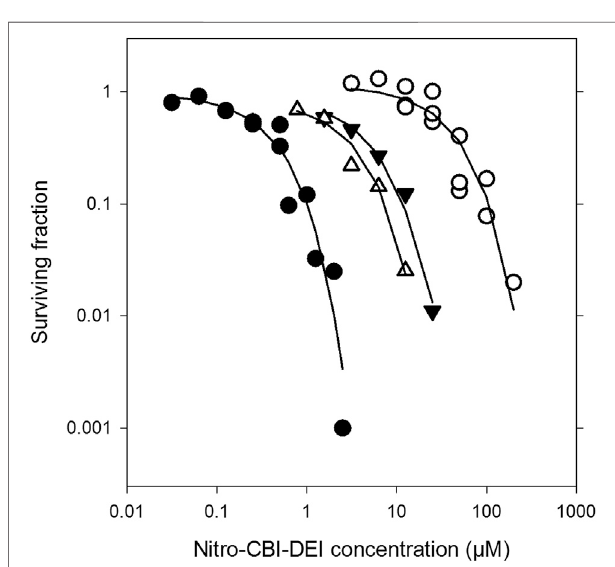
FIGURE 7 | Clonogenic cell killing by nitro-CBI-DEI in spheroid co- cultures with HCT-116 nfsA -null and HCT-116:11_78 cells. HCT-116:11_78 and TagRFP657-expressing nfsA -null HCT-116 cell lines were grown in spheroid mono- or co-culture for 4 days. Spheroids were challenged with nitro-CBI-DEI for 5 h after which they were dissociated and plated in selective media to determine clonogenic cell survival. In parallel, untreated spheroids were phenotyped with pimonidazole and analyzed by fl ow cytometry (see Supplementary Figure S2 ). Closed circles: mono-cultures with HCT-116:11_78 cells; open circles: mono-cultures with HCT-116 nfsA - null cells; closed triangles: HCT-116 nfsA -null cells in co-culture with 10.5% pimonidazole-positive HCT-116:11_78 cells; open triangles: HCT-116 nfsA - null cells in co-culture with 33% pimonidazole-positive HCT-116:11_78 cells (phenotyping data not shown). Survival curves for each of the mono-cultures were from three pooled separate experiments.